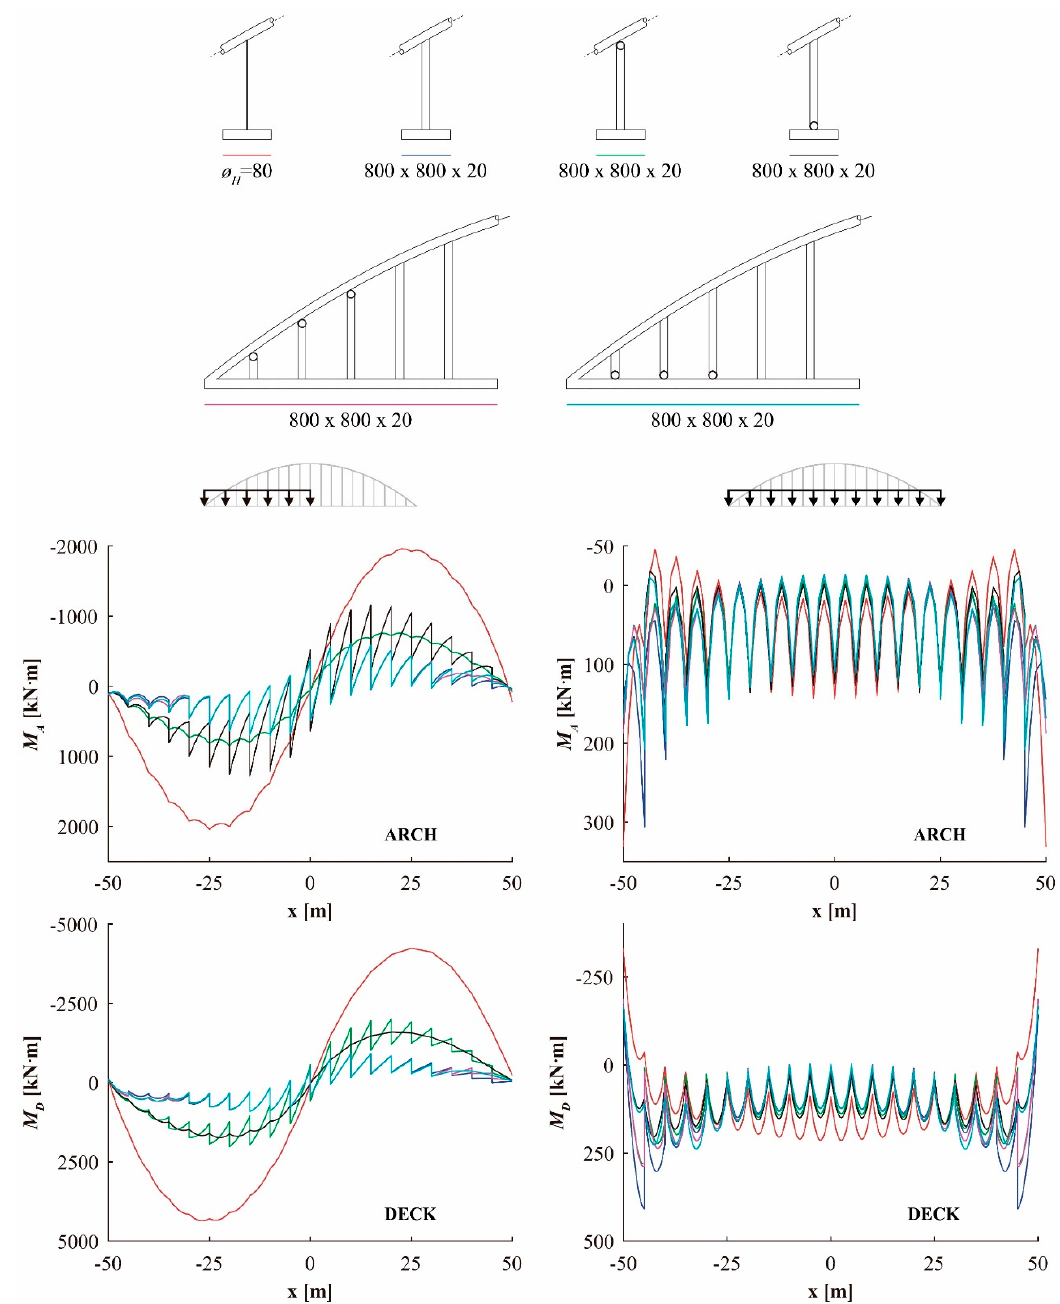
Figure 14. Bending moments for stiff and pinned hanger distribution.